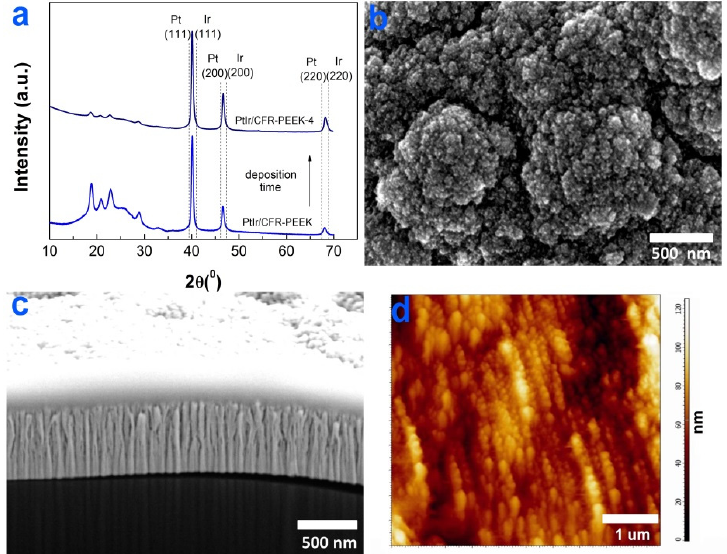
Figure 5. Characterization of PtIr films: XRD patterns of PtIr/CFR-PEEK, PtIr/CFR-PEEK-4 ( a ), SEM surface micrograph of PtIr/CFR-PEEK ( b ), AFM micrograph of PtIr/CFR-PEEK-4 ( c ), and FIB-SEM cross-section micrograph of PtIr/CFR-PEEK ( d ).